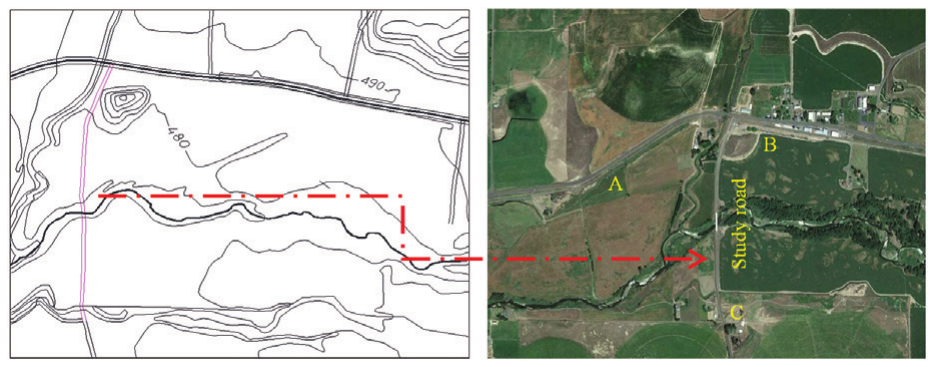
Fig. 1. Study road overview